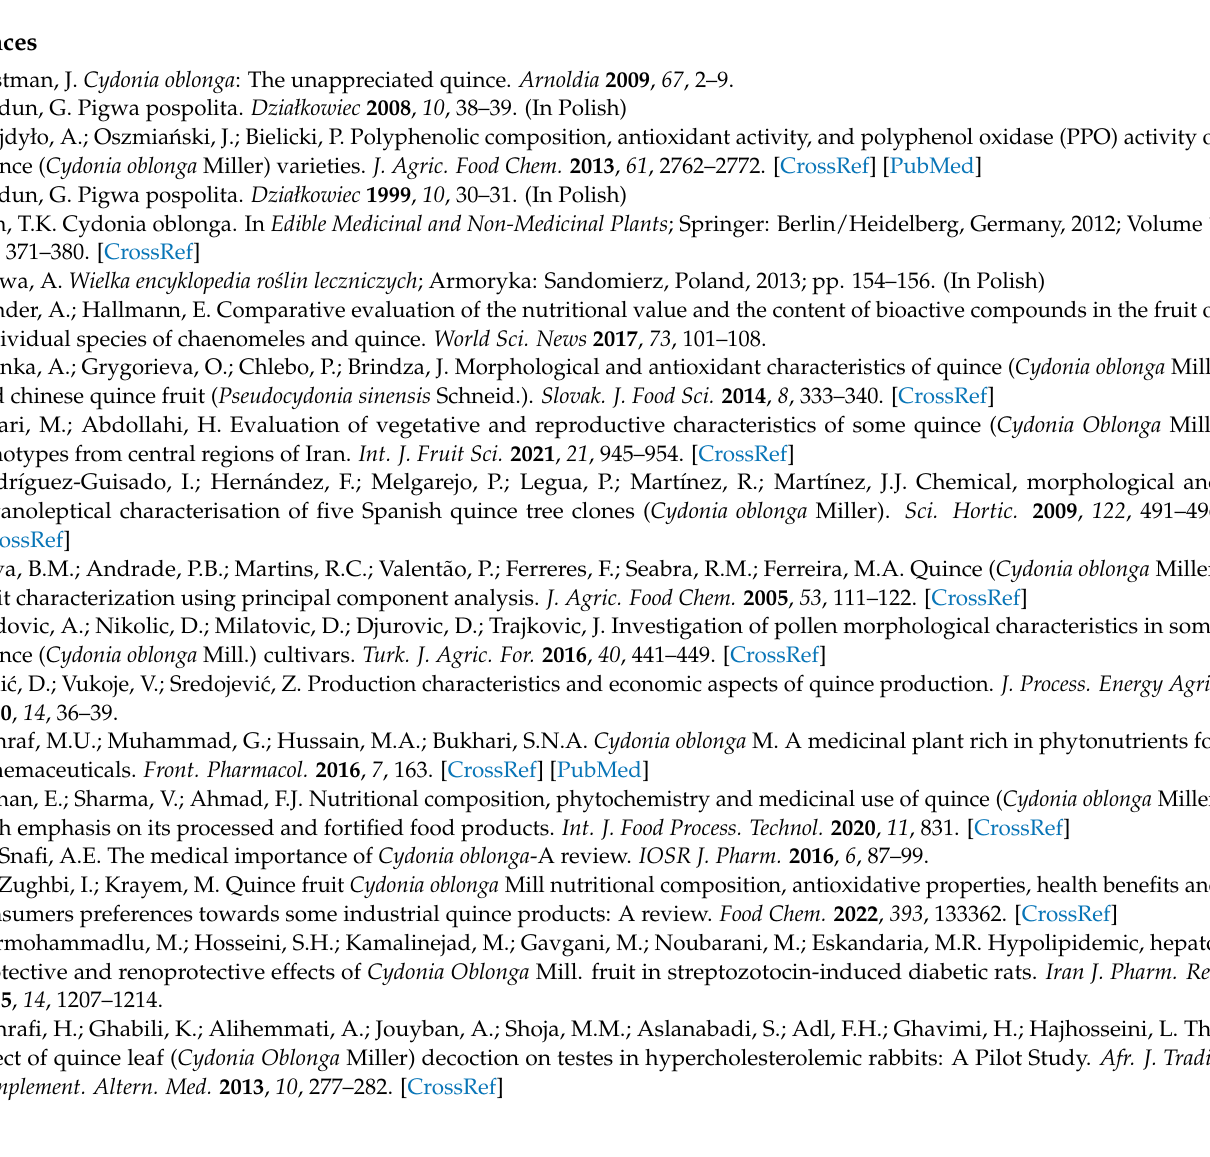
Figure S5: The picture of spectra of carotenoids analysis in fresh quince fruit; Figure S6: The picture of spectra of polyphenols analysis in quince fruit dried in 50 ◦ C; Figure S7: The picture of spectra of carotenoids analysis in quince fruit dried in 70 ◦ C; Figure S8: The picture of spectra of carotenoids analysis in quince fruit